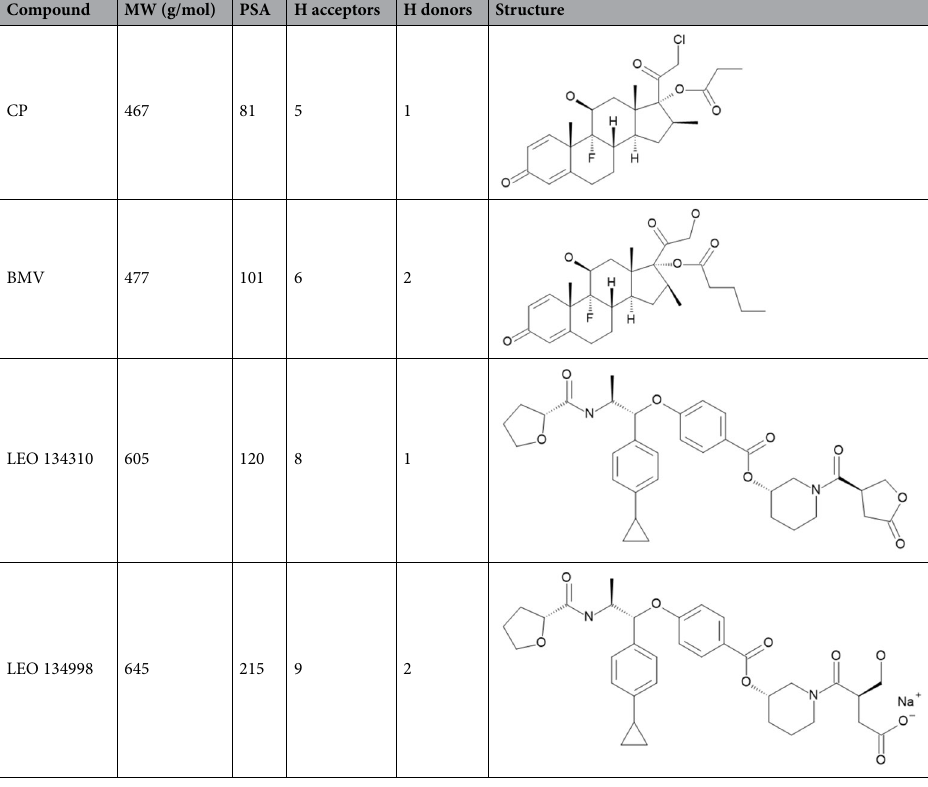
Table 1. Structures and calculated properties of LEO 134310, metabolite (LEO 134998) and reference GCs Clobetasol Propionate (CP) and Betamethasone Valerate (BMV). H acceptors hydrogen bond acceptors, H donors hydrogen bond donors, PSA polar surface